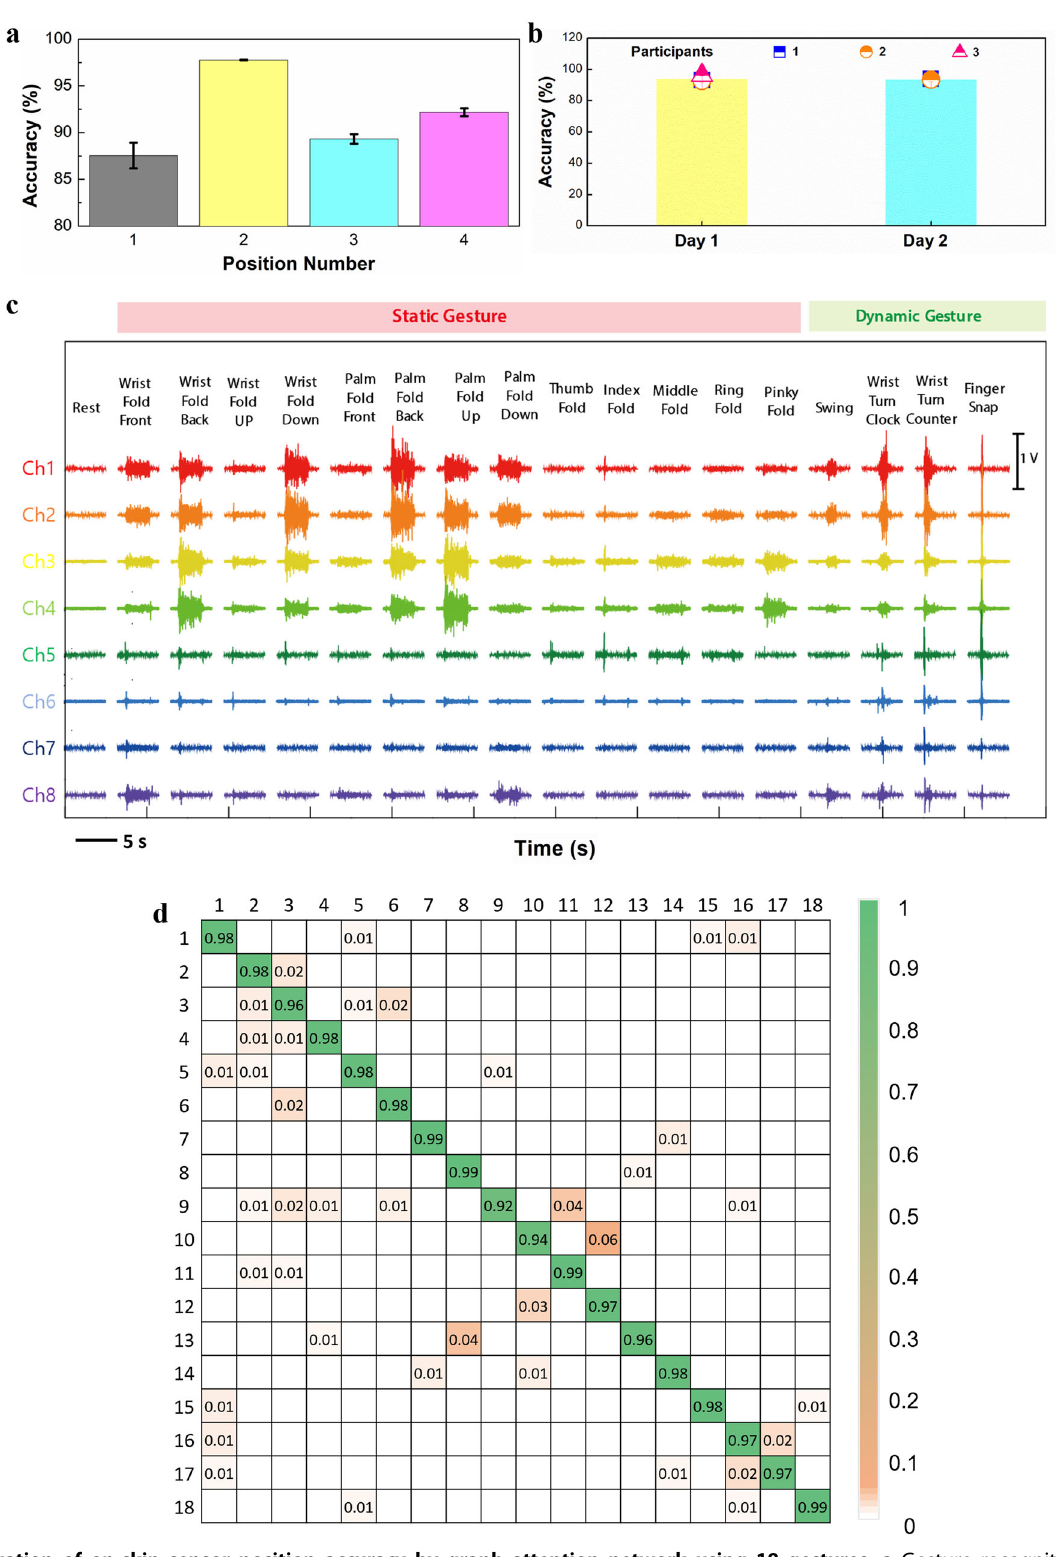
Fig. 4 Evaluation of on-skin sensor position accuracy by graph attention network using 18 gestures. a Gesture recognition accuracy corresponds to four positions of the sensor attached to the skin. b Gesture recognition accuracy among three participants wearing sensors at position 2 of day 1 and day 2. c 8-channel raw sEMG signals of participant 1 for sensor position 2 under 18 gestures. d Explicit representation of gesture recognition accuracy for sensor position 2 in the form of the Confusion